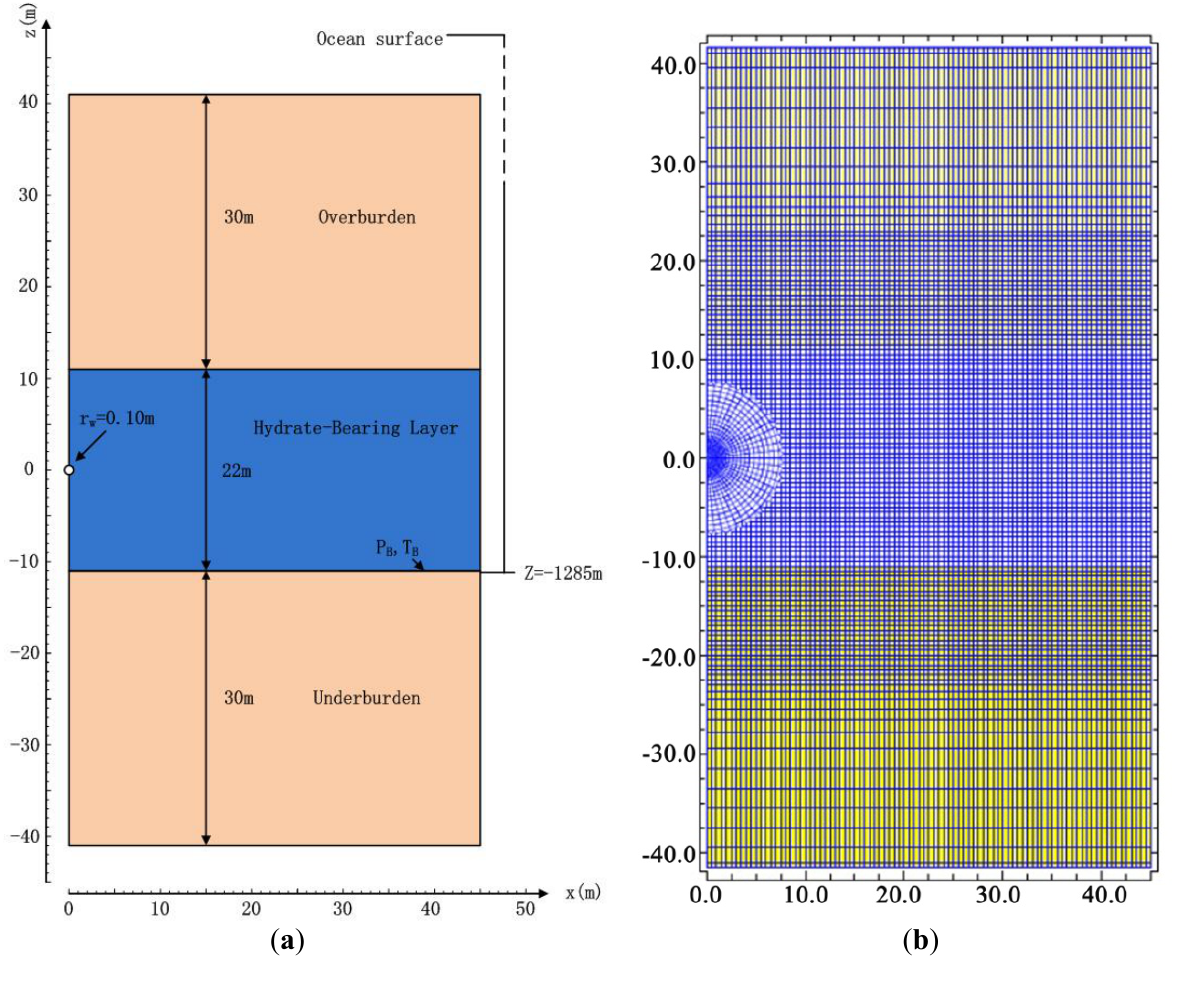
Figure 3. ( a ) A schematic of the marine hydrate deposit at the SH7 site of the Shenhu Area, South China Sea; ( b ) The grid used in the